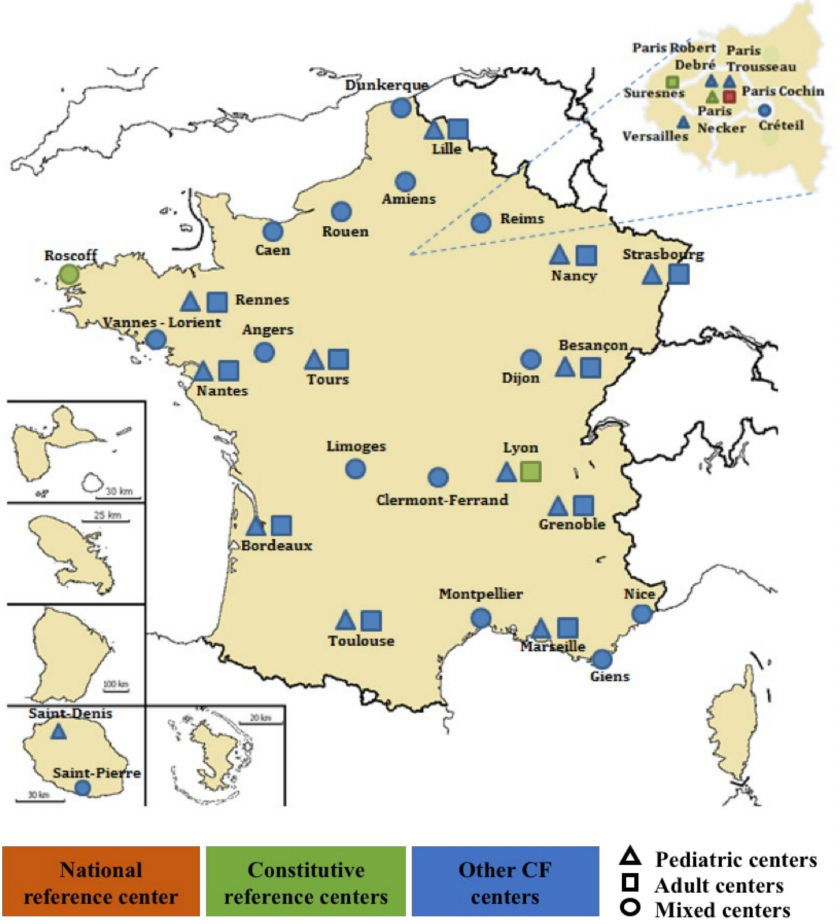
Figure 3. The French Cystic Fibrosis Reference Network.Upper insert: greater Paris area. Bottom left insert: La R é union